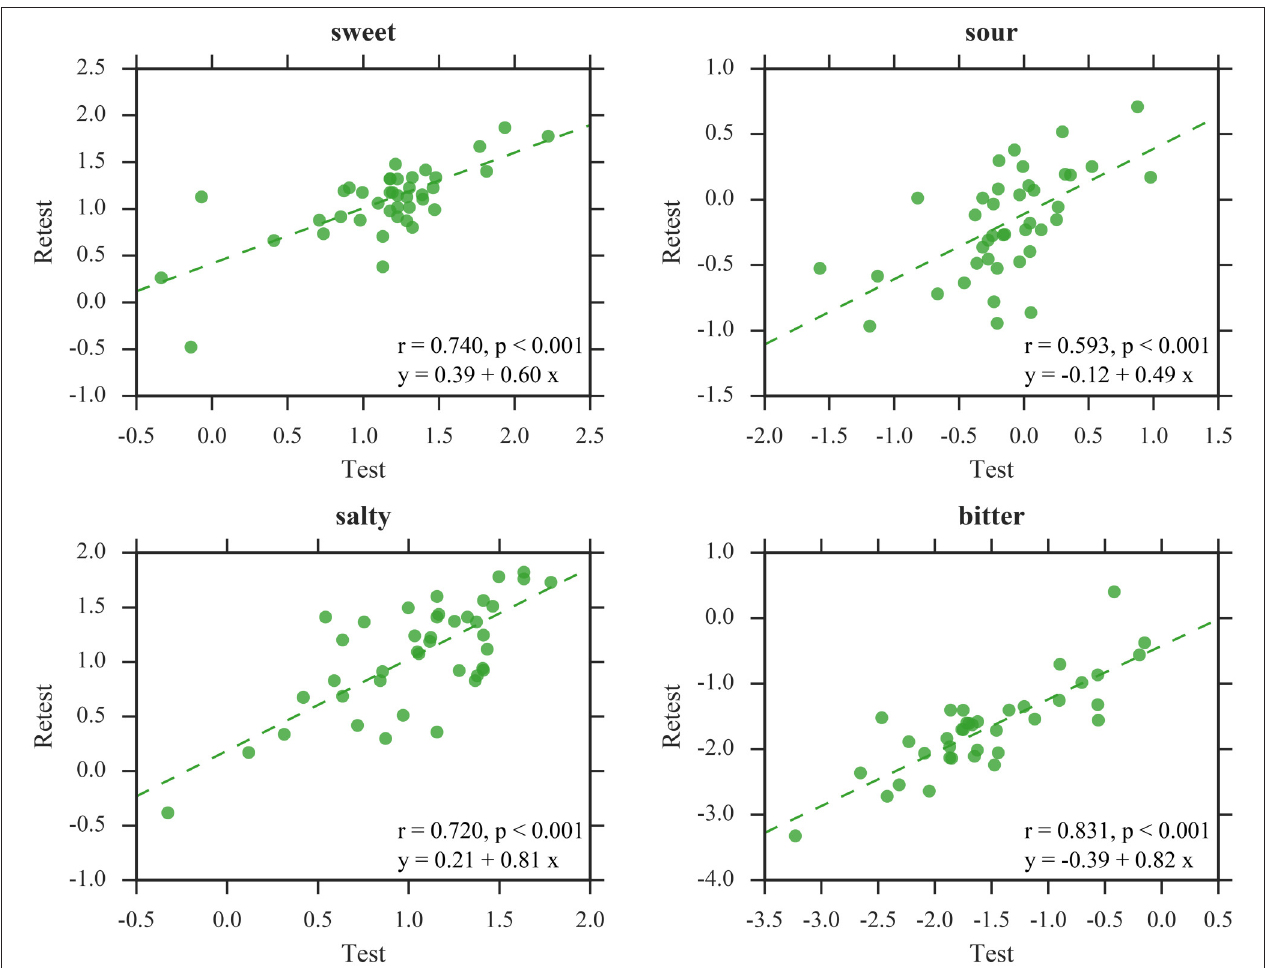
FIGURE 8 | Test-retest correlations of QUEST thresholds. All values in log 10 m M